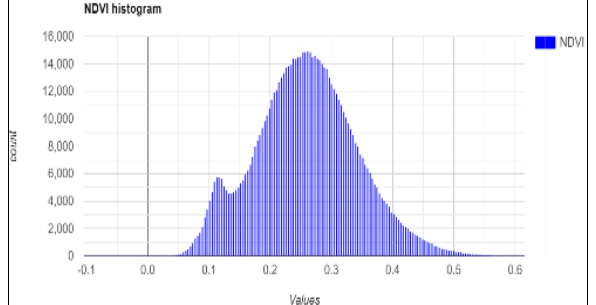
Figure 6 . Thresholding NDVI